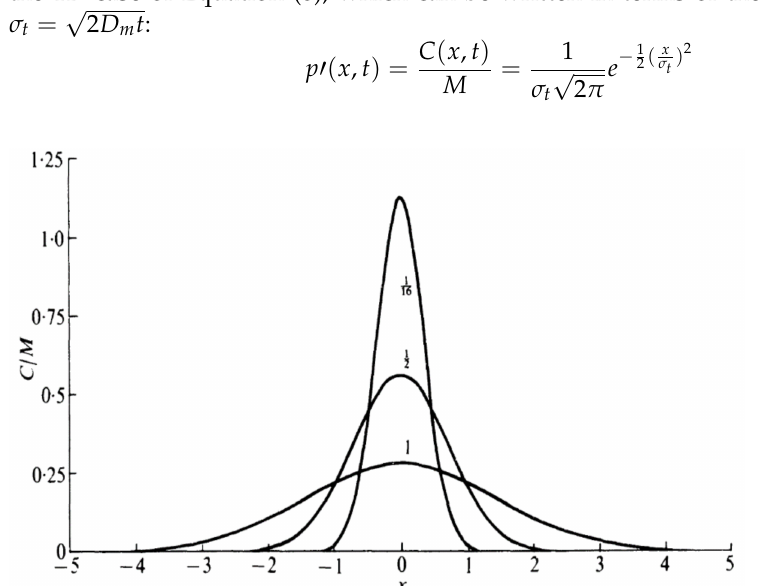
Figure 4. Regular Gaussian probability functions for the spatial concentrations C / M at different times, scaled by values of Dt (1/16th, 1 and 1 [L 2 ]) due to 1D diffusion. The vertical scale has a 2 dimension of [L − 1 ]. After Crank